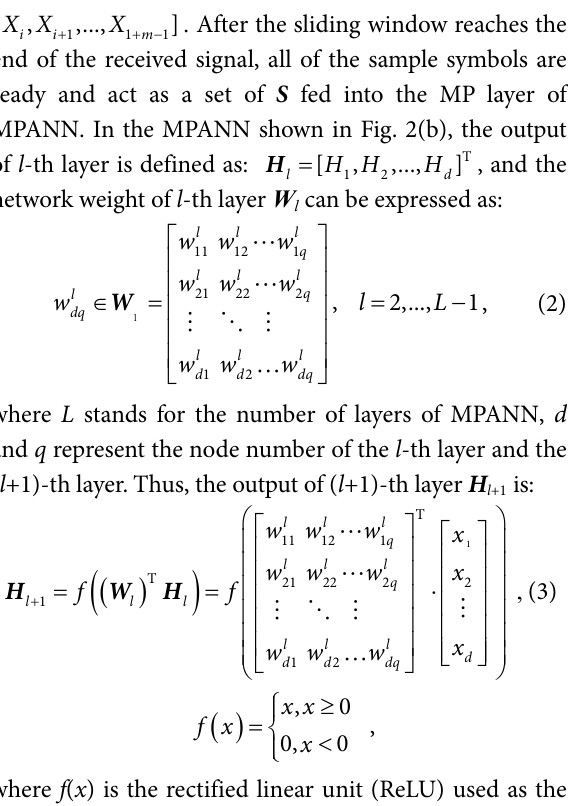
Fig. 2 | ( a ) The schematic of the MPANN equalization pre-processing for the received symbols. ( b ) The structure of the applied MPANN. ( c ) The structure of the DNN for